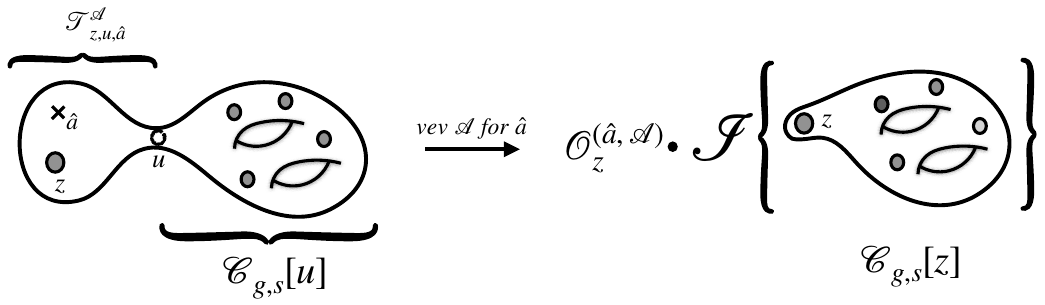
Figure 1: Derivation of the A ∆ O from the index. We denote both the flux of the three punctured sphere we glue in and the preferred choice of the operator we give the vev to by A , as the resulting two punctured sphere has zero